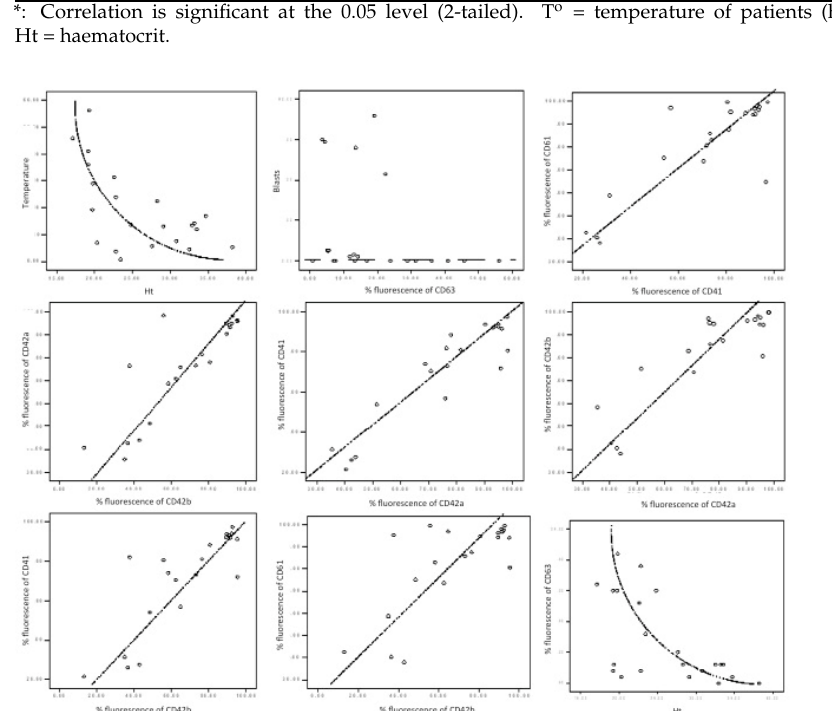
Table 4. Platelets’ antigens distribution in AML patients with or without bleeding. Markers